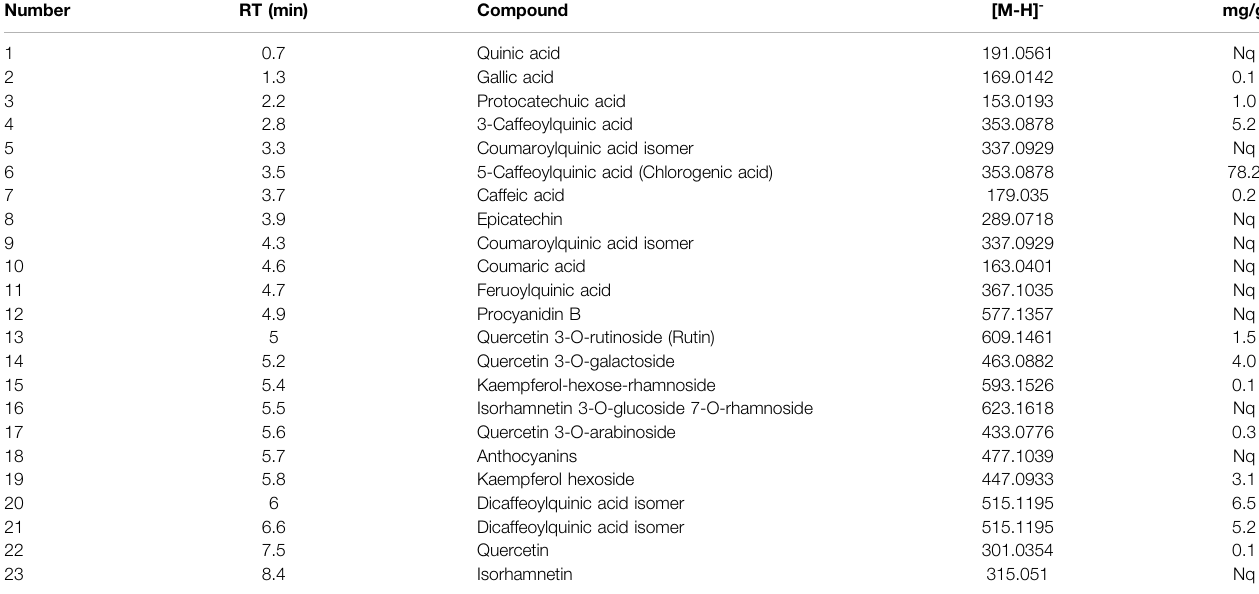
TABLE 3 | Identi fi cation and quanti fi cation (mg/g of dried plant) of compounds in H. lanceolatum aqueous extract by LC-MS/MS. Results are expressed as mean in mg/g. RT, retention time. Nq, not quanti fi ed. Number RT